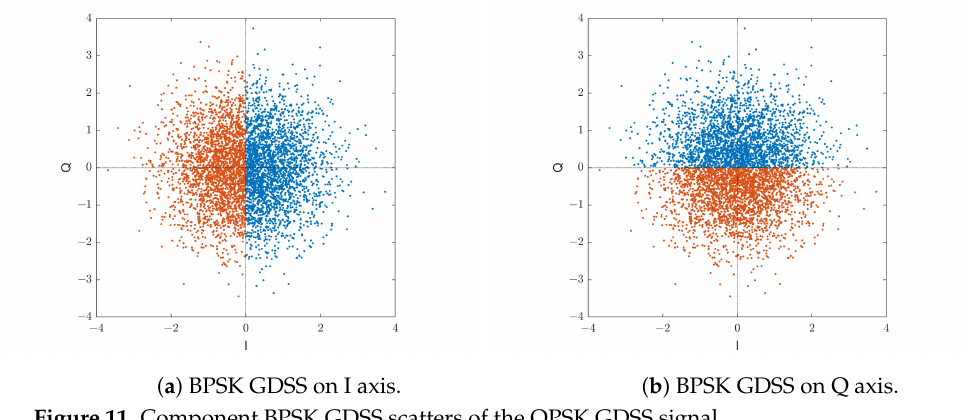
Figure 11. Component BPSK GDSS scatters of the QPSK GDSS